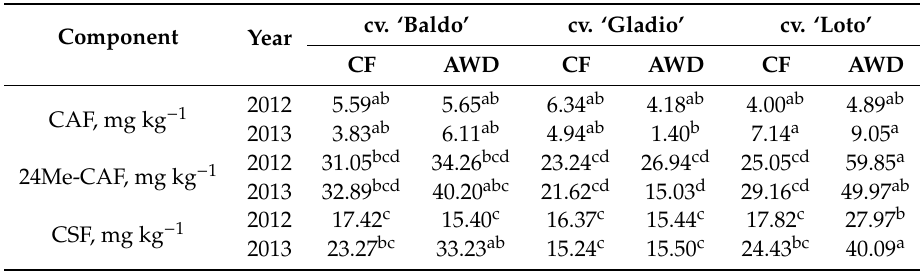
Table 5. Concentrations of the γ -oryzanol complex components in the brown grain of three rice cultivars grown under continuous flooding (CF) or alternate wetting and drying (AWD). cv. ‘Baldo’ cv. Component Year